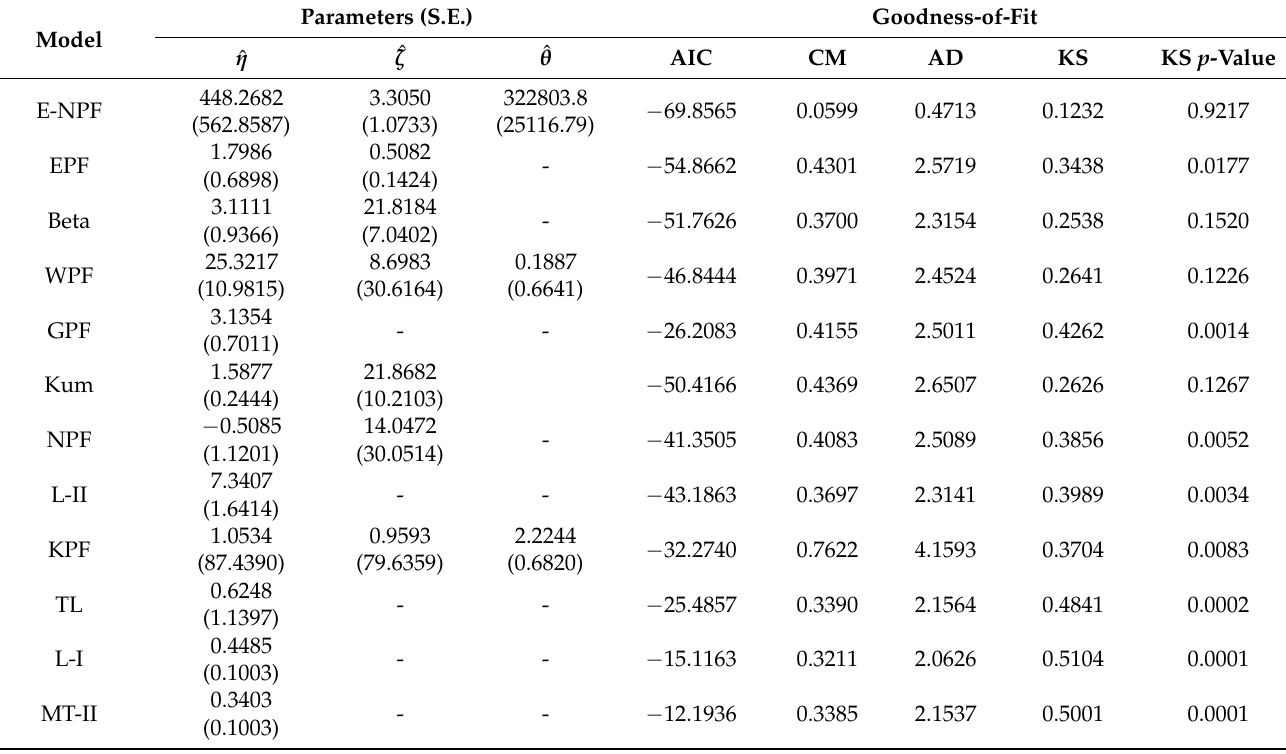
Table 11. Parameter estimates, S.E., and information criterion for failure times of 20 mechanical components data. Model